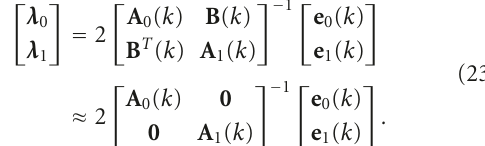
Figure 4: Sample power spectrum of u ( k